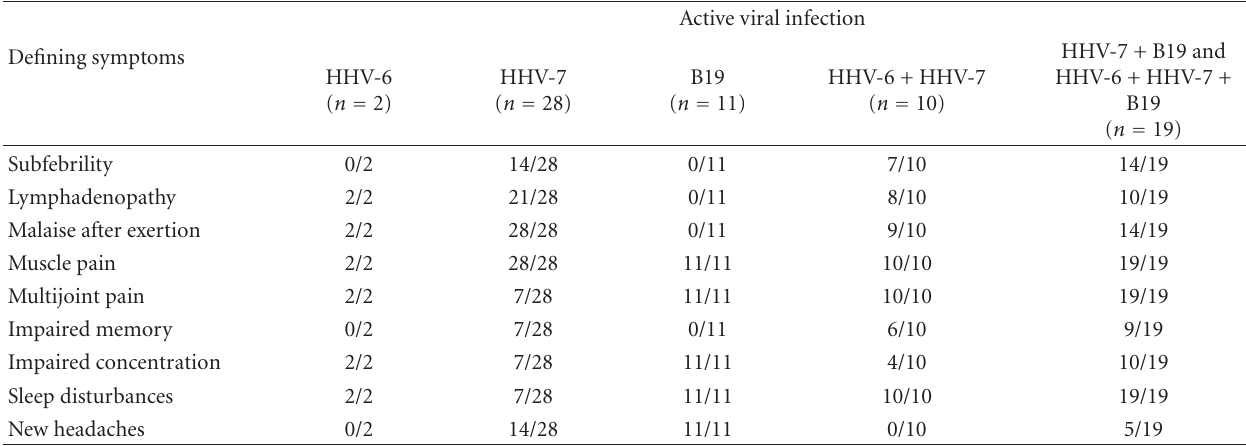
Table 3: Symptoms of ME/CFS in patients with active viral infection/coinfection.